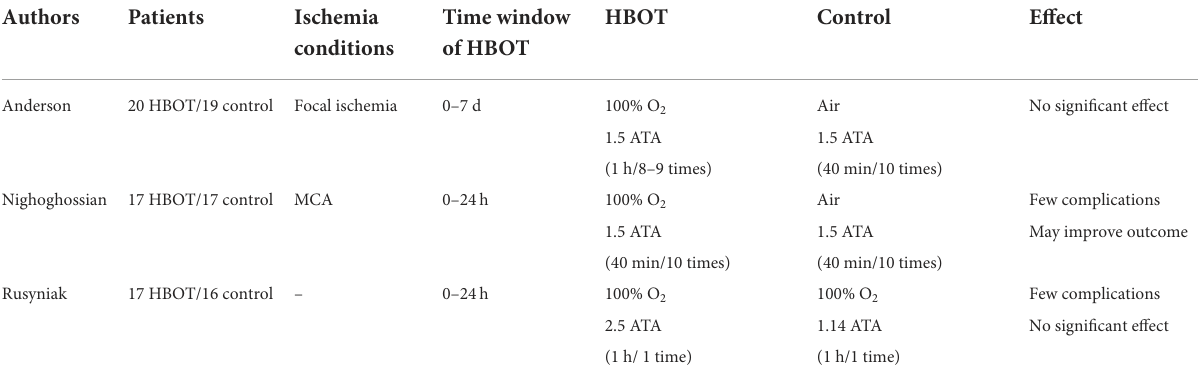
TABLE 2 Randomized controlled trials of HBOT in